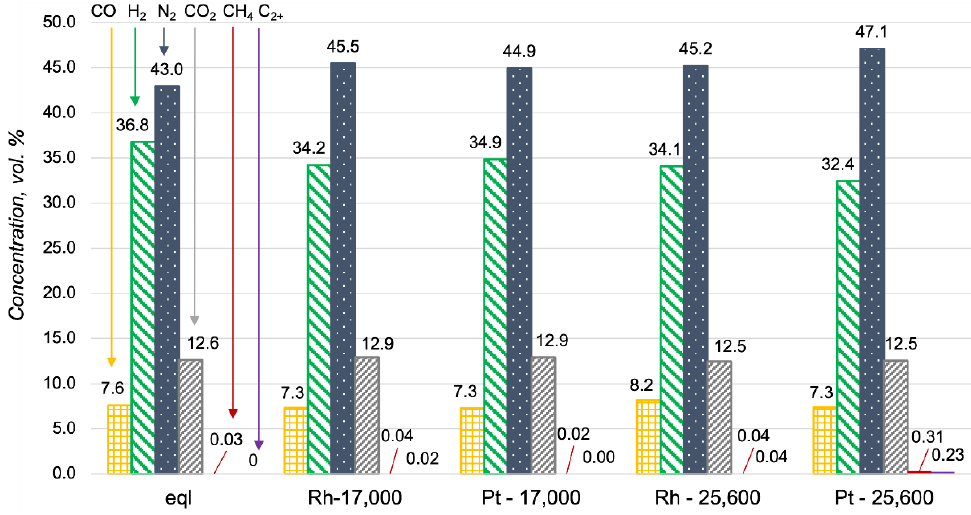
Figure 7. Product distribution in propane oxidative steam reforming at 700 °C with H 2 O/C = 2.5 and O 2 /C = 0.5 in a thermodynamic equilibrium (eql), over the Rh/CZA/FeCrAl and the Pt/CZA/FeCrAl at GHSV = 17,000 h − 1 (“Rh—17,000” and “Pt—17,000”, respectively), and over the Rh/CZA/FeCrAl and the Pt/CZA/FeCrAl at GHSV = 25,600 h − 1 (“Rh—25,600” and “Pt—25,600”, respectively).